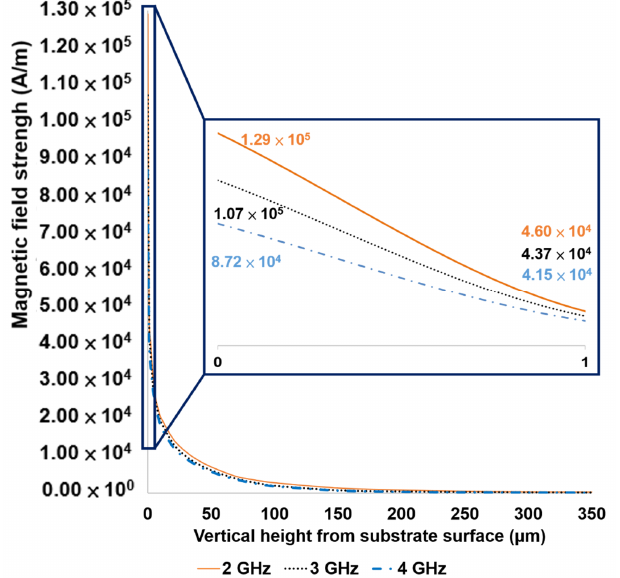
Figure 7. Maximum magnetic field strength versus vertical height of reference plane at different operating frequencies (2, 3, and 4 GHz).